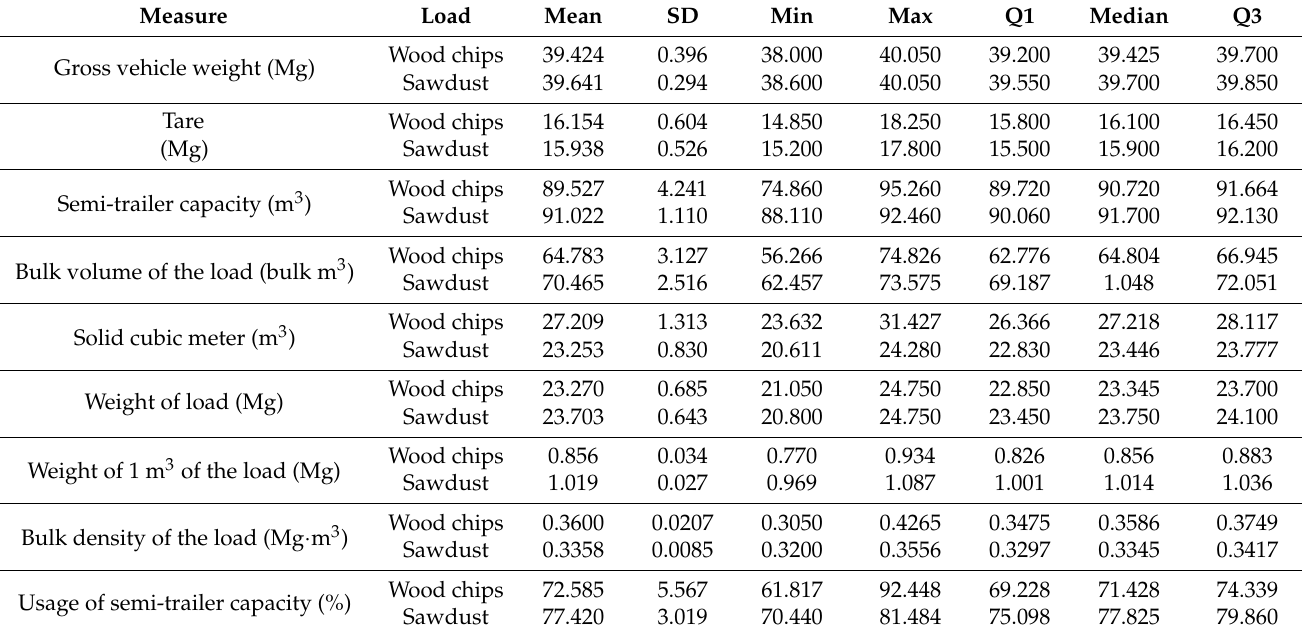
Table 1. Selected measurements by type of load.